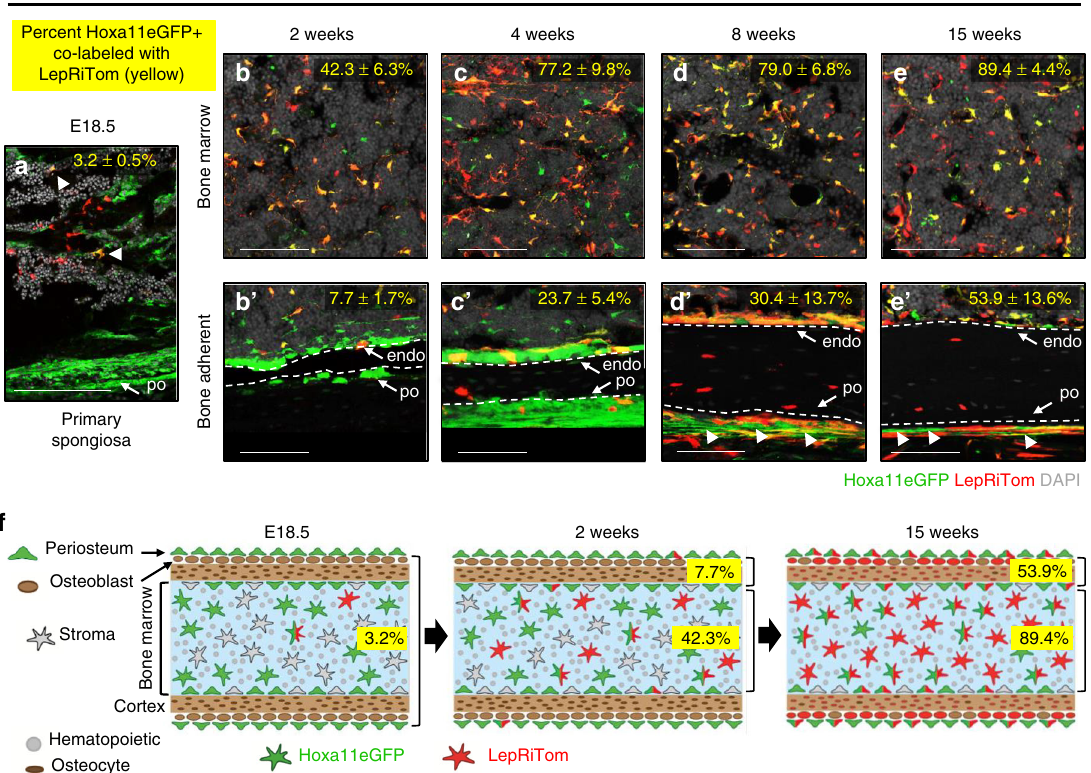
Fig. 7 LepR-Cre progressively marks existing Hoxa11eGFP-positive cells. Analysis of the co-expression of Hoxa11eGFP (green) and LepR-Cre lineage-marked cells (LepRiTom, red) in Hoxa11eGFP;LepR-Cre;ROSA-tdTomato mice. Percentages (yellow) re fl ect proportion of Hoxa11eGFP-positive cells that also express LepRiTom. Flow cytometry analyses shown in Supplementary Fig. 5. a magni fi ed view of primary spongiosa and developing cortical bone surface at E18.5 ( n = 3). b – e ′ High magni fi cation view of mid-diaphysis of ulna b – e bone marrow, or b ′ – e ′ cortical bone at 2 ( n = 4), 4 ( n = 3), 8 ( n = 3), and 15 weeks (n = 3). d ′ , e ′ Arrowheads identify non-overlapping Hoxa11eGFP-positive periosteal cells. In all images; gray: DAPI. Data presented as mean ± standard deviation. ‘ n ’ values indicate pooled cells from a both E18.5 forelimbs or b – e ′ the radius and ulna of one forelimb of biologically independent animals for each time point. f Diagram of data at E18.5, 2 weeks, and 15 weeks. All scale bars: 100 μ